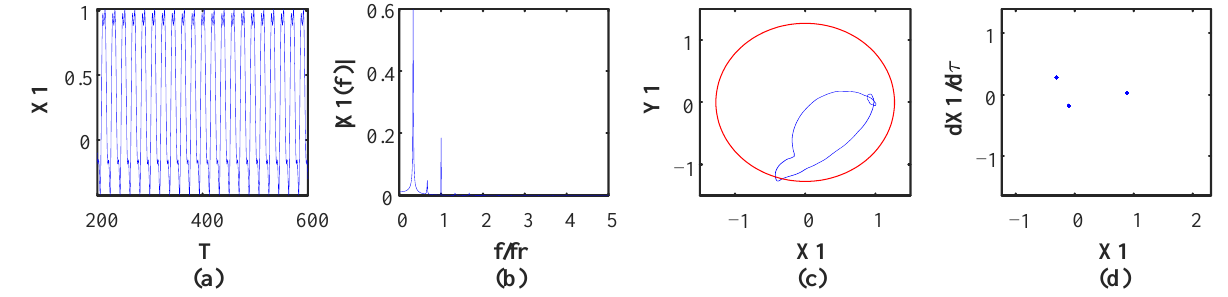
Figure 11. Numerical integration results at ω = 1190 rad/s: ( a ) Time domain waveform; ( b ) Frequency spectrum; ( c ) Shaft orbit; ( d ) Poincar é